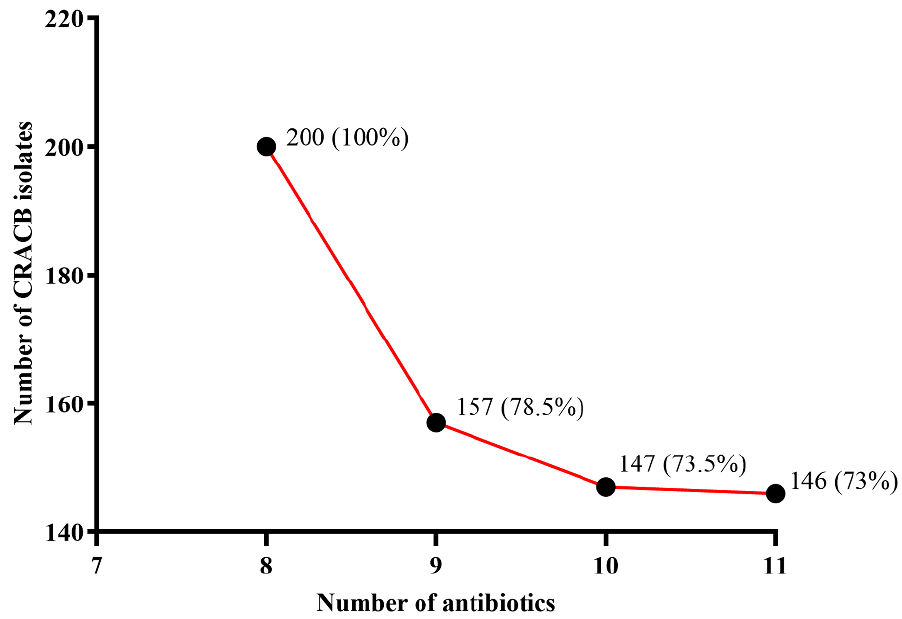
Figure 2. CRACB isolates concurrently resistant to the WHO AWaRe group of antibiotics. All the isolates were resistant to eight antibiotics.